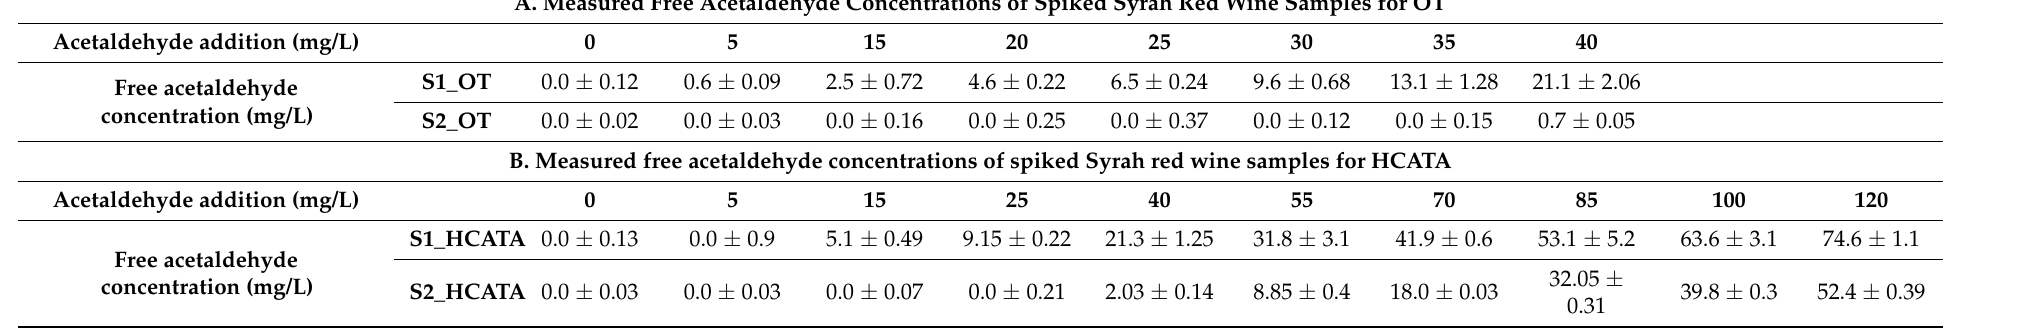
Table 3. Free acetaldehyde concentrations measured by HS-GC-MS of the spiked Syrah red wine samples for OT (A) and HCATA analysis (B). Values represent means of triplicate determination ± standard